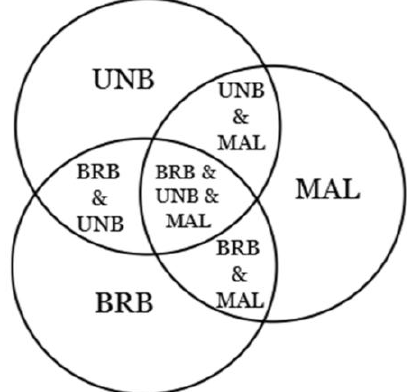
Figure 11. Combination for multiple-combined fault